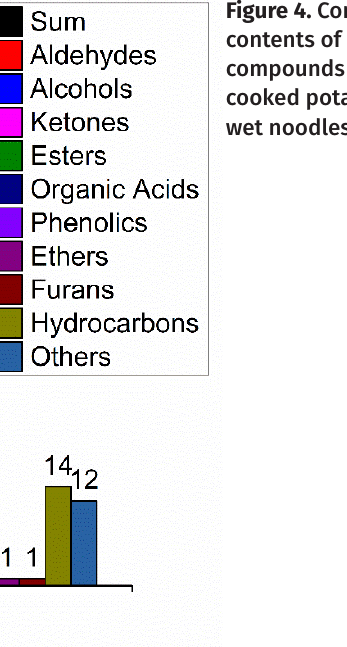
Figure 4. Comparison the compounds in raw and wet